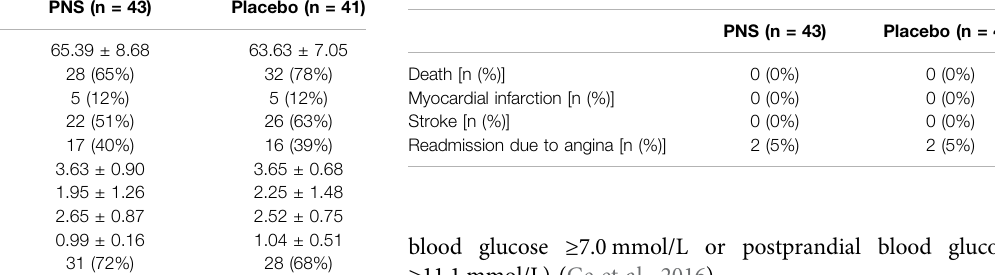
TABLE 1 | Comparison of characteristics between PNS and the placebo group. TABLE 2 | Adverse cardiovascular events 60 days after treatment between PNS and the placebo